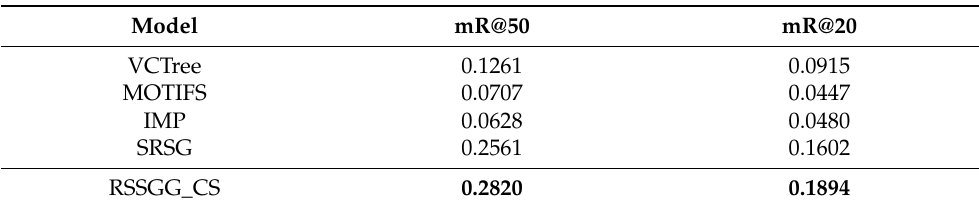
Table 3. Comparison between previous models and RSSGG_CS for remote sensing image scene graph generation.